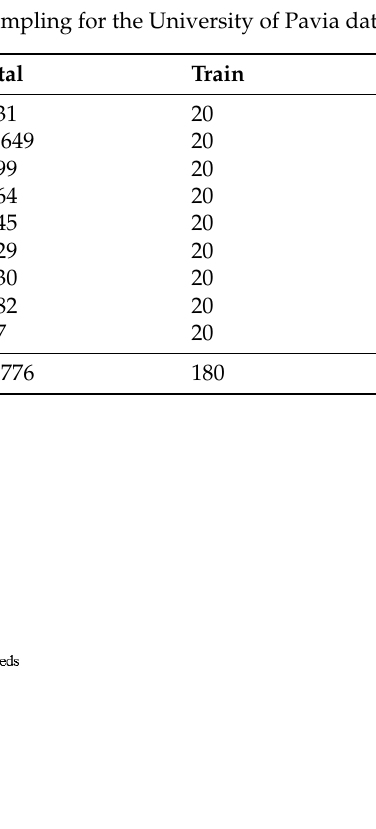
Figure 7. ( Left ) False color image and ( Right ) ground truth map of the Salinas dataset. Table 2. The numbers of the training and testing sampling for the Salinas